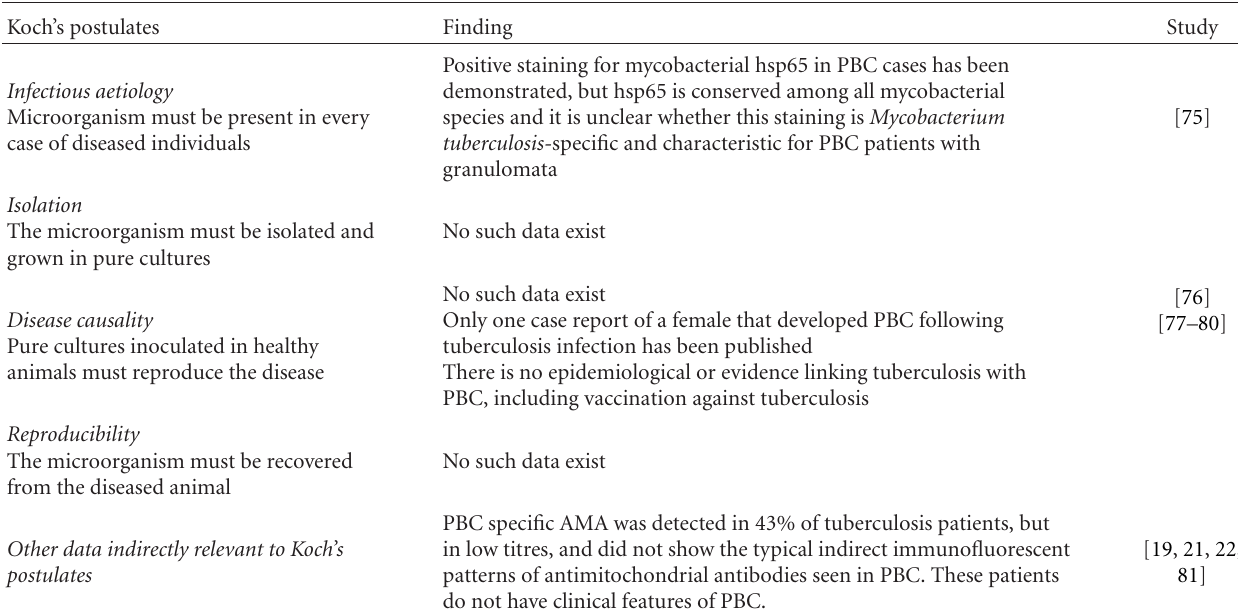
Table 1: Summary of the major findings of studies investigating the role of Mycobacterium tuberculosis as a trigger of PBC. The findings are presented in relation to Koch’s postulates. To date, no conclusive evidence has been presented which links Mycobacterium tuberculosis with